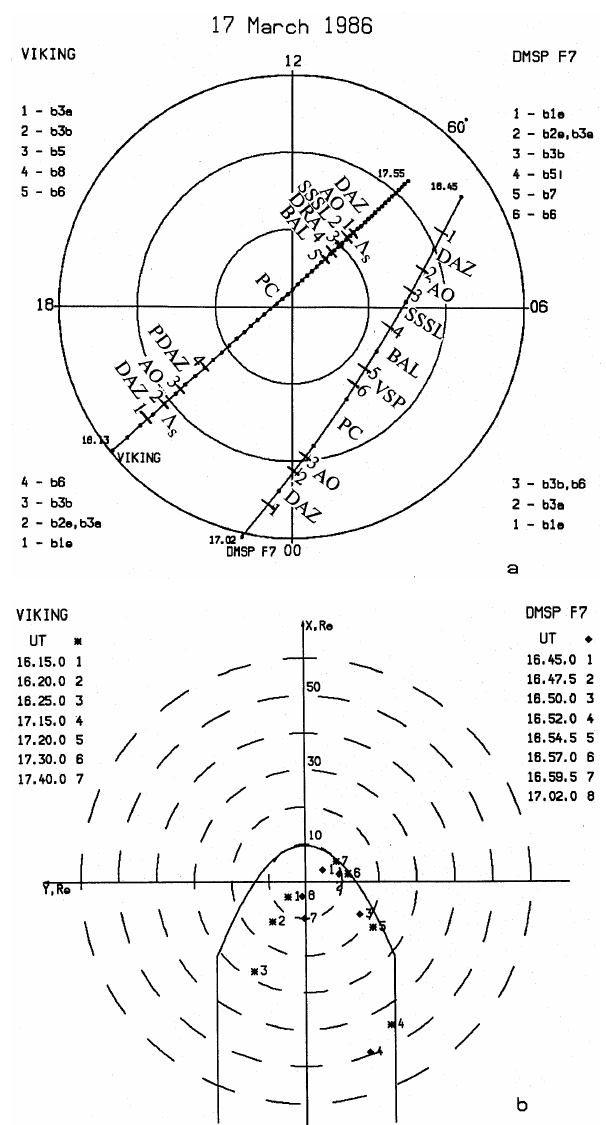
Fig. 1. (a) Trajectories of the Viking and DMSP satellites and plasma regimes in the high-latitude region of the northern hemi- sphere on 17 March 1986. Dots mark satellite positions every 2 min, and 2.5 min, respectively. Plasma regime boundaries are marked and their notations are presented for DMSP to the right, and for Viking, to the left; (b) projections of the trajectory points to the magnetospheric equatorial section, using the Tsyganenko (1995) model. Numbers are used to mark the UT moments for which the satellite’s coordinates are shown in the spectrograms in Fig. 2 and Fig. 5. They identify the various boundaries, separately for the dawn and dusk part of the